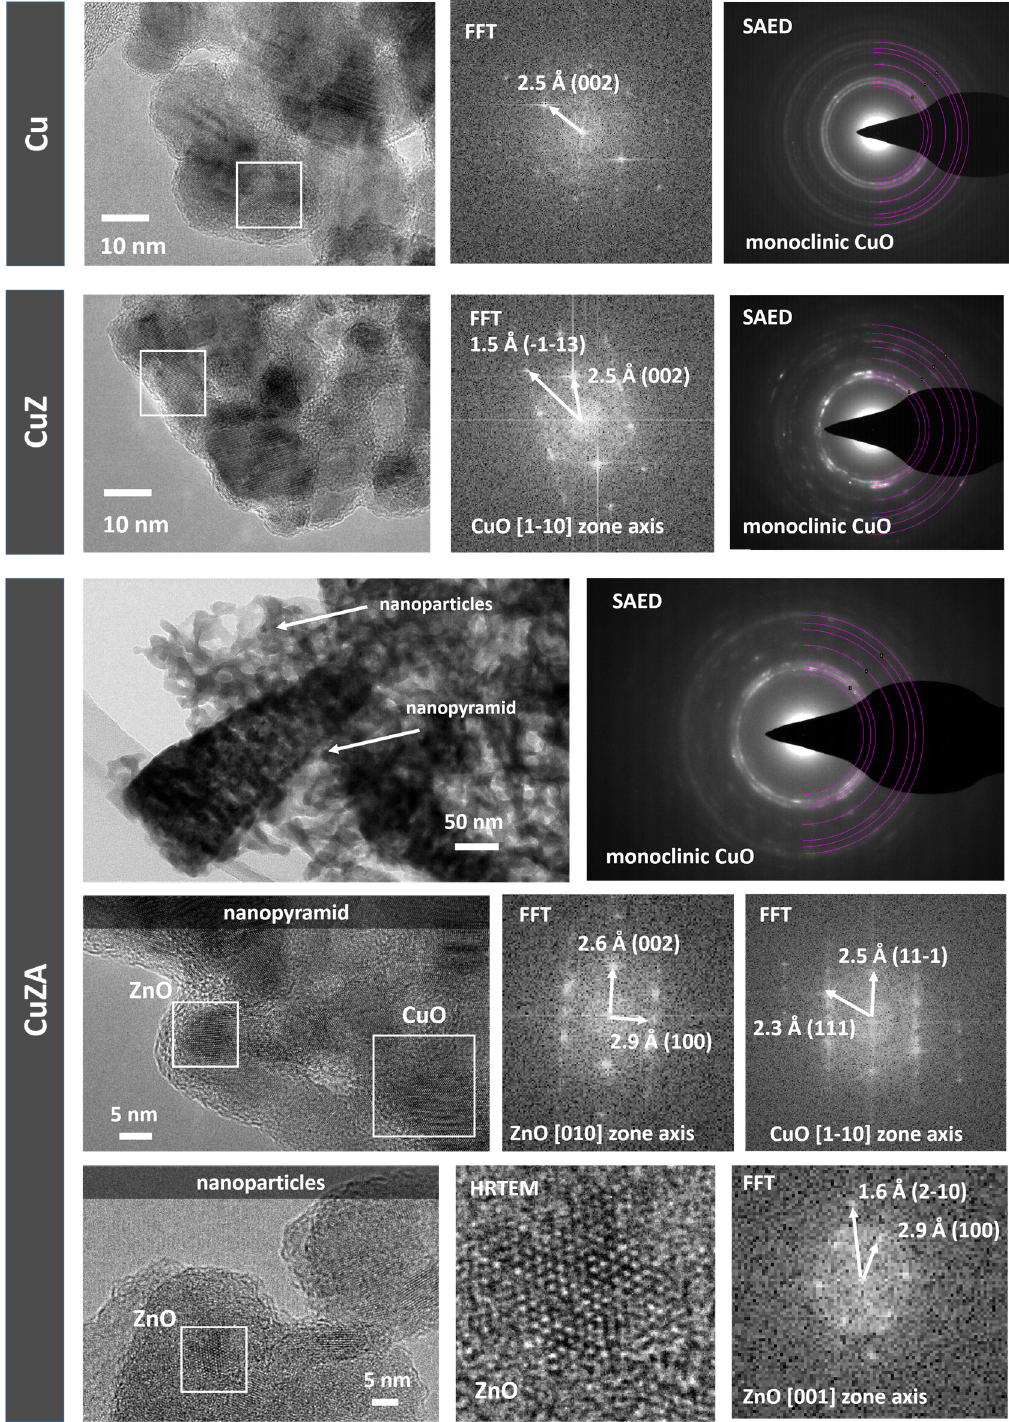
Figure 6. TEM analysis for samples Cu-06, CuZ-06-03, and CuZA-06-03-1. Fast Fourier transforms (FFT) of the highlighted regions are provided, alongside selected area electron diffraction (SAED) patterns and a high-resolution TEM (HRTEM) image of a ZnO crystalline domain in sample CuZA-06-03-01.